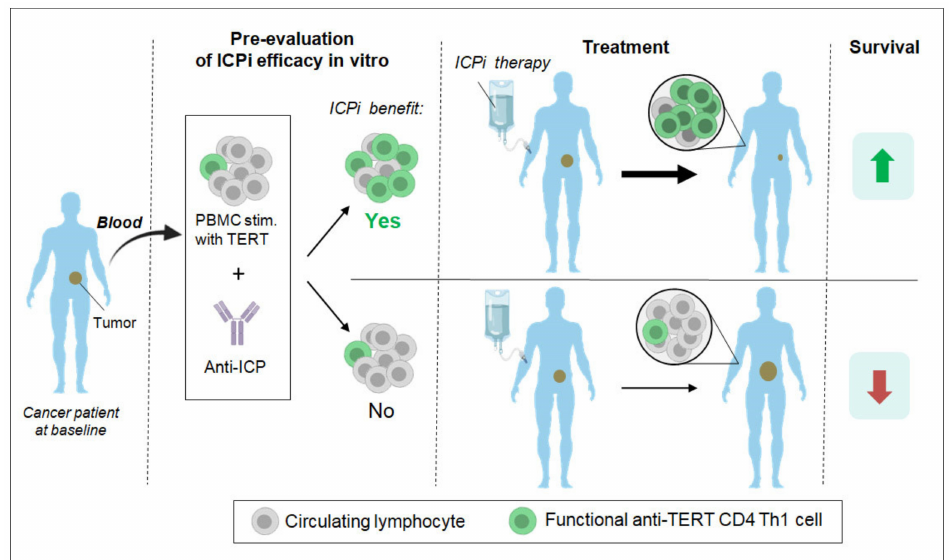
Figure 2. Proposed strategy to identify cancer patients most likely to respond to immune checkpoint inhibitors (ICPi) therapy. We propose to select patients for ICPi therapy based on an in vitro stimulation experiment evaluating the capacity of ICP blockade to stimulate systemic anti-TERT CD4 T cell immunity. Peripheral blood mononuclear cells (PBMC) from patients collected at the baseline would be stimulated with MHC-II TERT peptides in the presence of anti-ICP antibodies. Since anti-TERT Th1 immunity was generally associated with a good prognosis [110–112], a drastic increase of anti-TERT response following ICP blockade in vitro would ensure that the patient can benefit from the